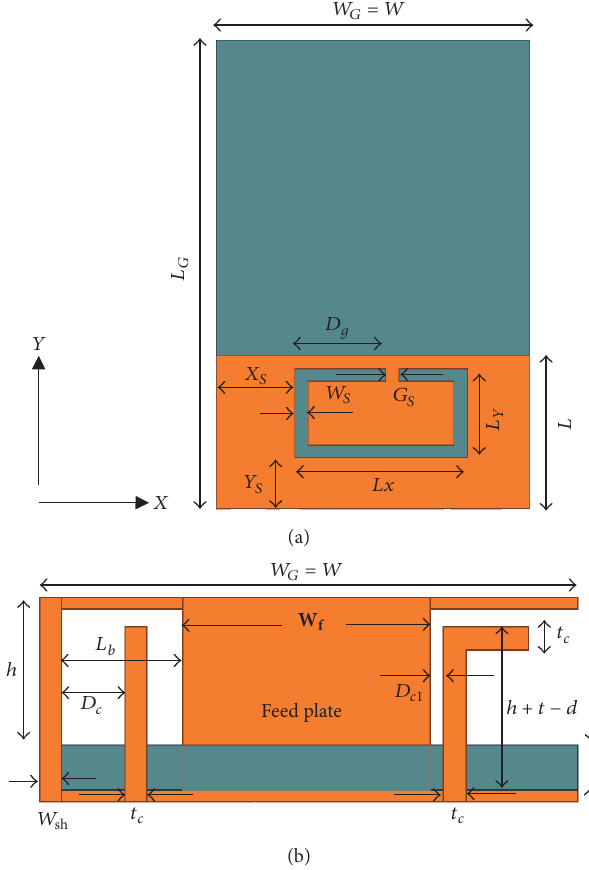
Figure 1: Geometry of an SRR based PIFA. (a) Top view; (b) side